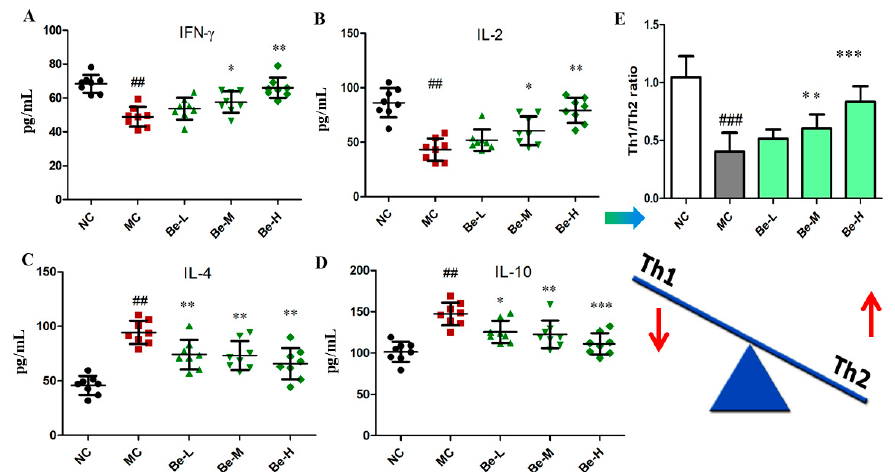
Figure 2. Effect of bergenin on cytokines in the Cy-treated mice serum. ( A ) Serum IFN- γ levels; ( B ) Serum IL-2 levels; ( C ) Serum IL-4 levels; ( D ) Serum IL-10 levels; ( E ) Th1 and Th2 cytokine ratio. NC: normal control group, dosed with saline; MC: model control group, challenged with cyclophosphamide; Be-L: challenged with Cy and treated with 5 mg/kg/day bergenin; Be-M: challenged with Cy and treated with 10 mg/kg/day bergenin; Be-H: challenged with Cy and treated with 20 mg/kg/day bergenin. Data are expressed as mean ± SD ( n = 8). ## p < 0.01 and ### p < 0.001 vs. the NC group, * p < 0.05, ** p < 0.01 and *** p < 0.001 vs. the MC group.